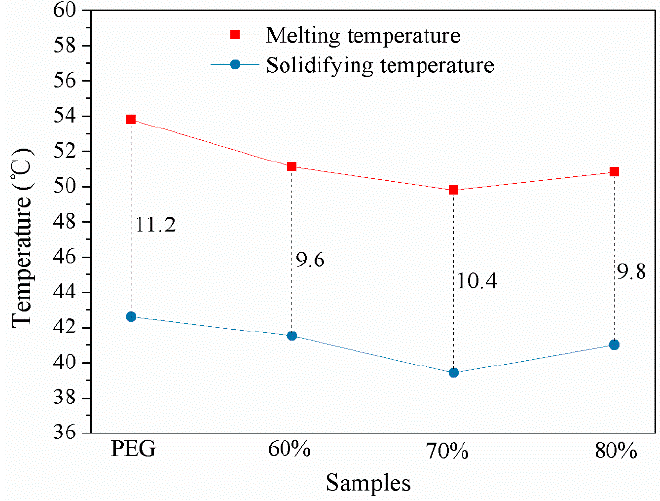
Figure 8. The extent of undercooling of PEG and PEG/NFMS.